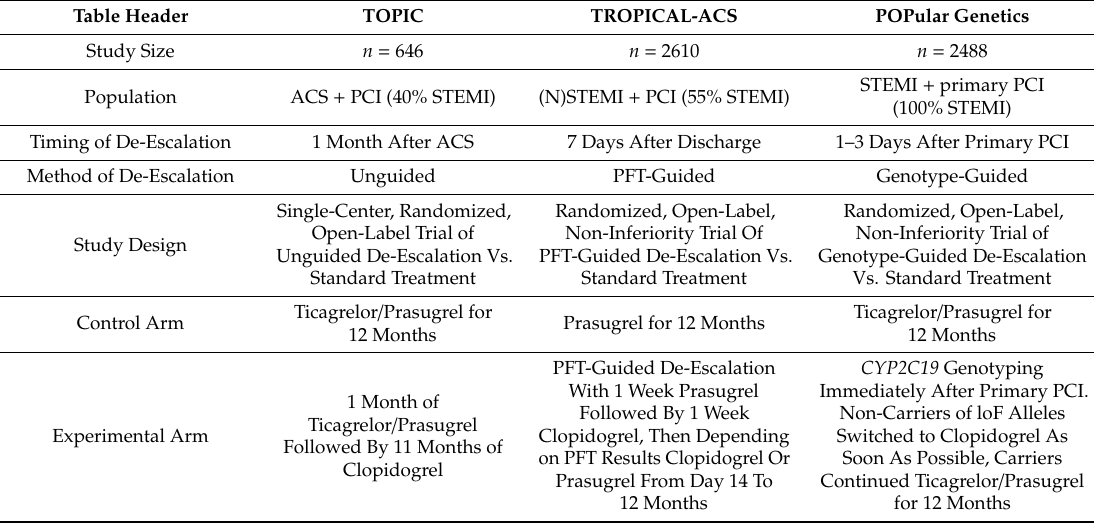
Table 1. Major randomized clinical trials investigating de-escalation of P2Y 12 inhibitor treatment in patients with